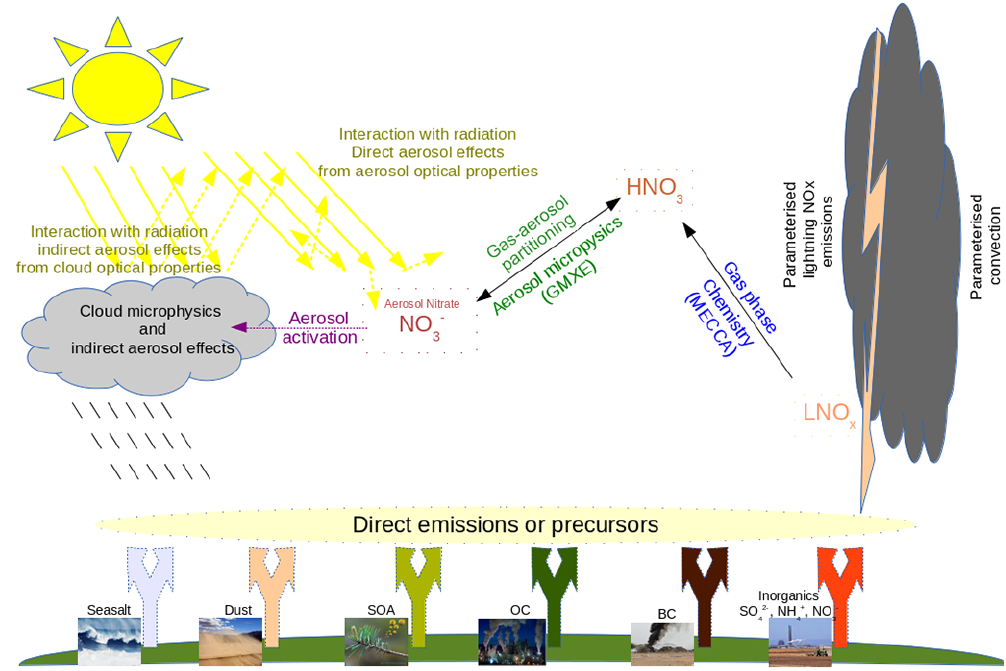
Figure 1. Sketch of the simulated processes from the emission of NO x molecules by lightning over gas-phase conversion to HNO 3 , gas aerosol partitioning to particulate NO − and implications for the direct and indirect aerosol 3